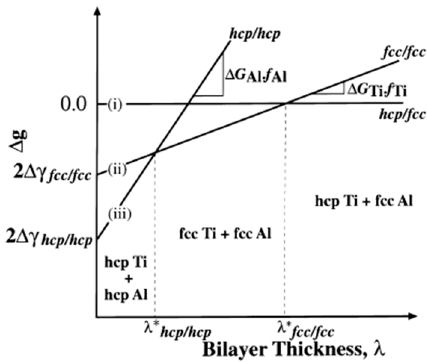
∆ g as a function of λ